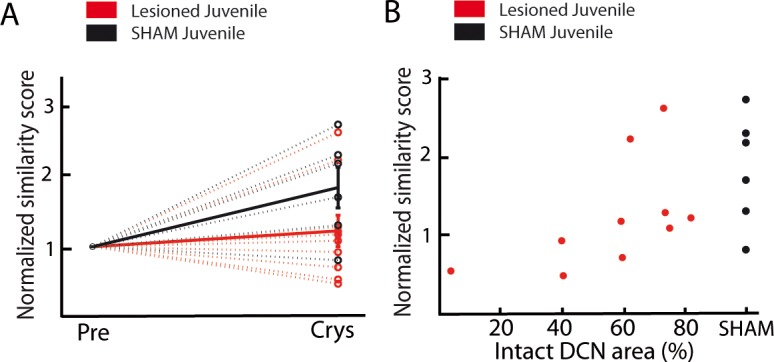
Effect of DCN lesions revealed by a custom-written similarity score based on the peak cross-correlation between the spectrograms of the tutor’s motifs and of the pupil’s songs.Among all songs produced by the pupil in each considered condition: before lesion or at crystallization (all recordings from a single day of recording were considered for analysis in each condition: pre-surgery or after crystallization), 10 randomly-selected songs were compared to the tutor’s selected motifs using the following procedure. Cross-correlations of the spectrograms were computed between all possible pairs defined as follows: a pair consisted in a tutor’s motif and a pupil’s song. For each pair, a cross-correlation index was calculated as the sum of the cross-correlation function between their two spectrograms, normalized by the square root of the product of their auto-correlation function. The average cross-correlation index over all 100 pairs was called the ‘spectral similarity index’ between tutor and juvenile in that condition. (A) Population data showing the evolution of similarity between the day before the lesion (pre) and the crystallization period (90 dph) in pupils with sham lesions (black dots for individuals, solid black line for the mean) and DCN lesions (red dots for individual, solid red line for the mean). Data are normalized over the pre-lesion period. (B) Normalized similarity score plotted as a function of the total area left from the lateral DCN (%) for juveniles with DCN lesion (red dots, n = 10 birds) or sham lesion (black dots, n = 6 birds). A significant correlation was revealed between the quality of the tutor song imitation and the proportion of lateral DCN left unaffected (Pearson correlation coefficient, r = 0.57, p<0.05).10.7554/eLife.32167.015Figure 7—figure supplement 3—source data 1.Source code for similarity score analysis.Among all songs produced by the pupil in each considered condition: before lesion or at crystallization (all recordings from a single day of recording were considered for analysis in each condition: pre-surgery or after crystallization), 10 randomly-selected songs were compared to the tutor’s selected motifs using the following procedure. Cross-correlations of the spectrograms were computed between all possible pairs defined as follows: a pair consisted in a tutor’s motif and a pupil’s song. For each pair, a cross-correlation index was calculated as the sum of the cross-correlation function between their two spectrograms, normalized by the square root of the product of their auto-correlation function. The average cross-correlation index over all 100 pairs was called the ‘spectral similarity index’ between tutor and juvenile in that condition.